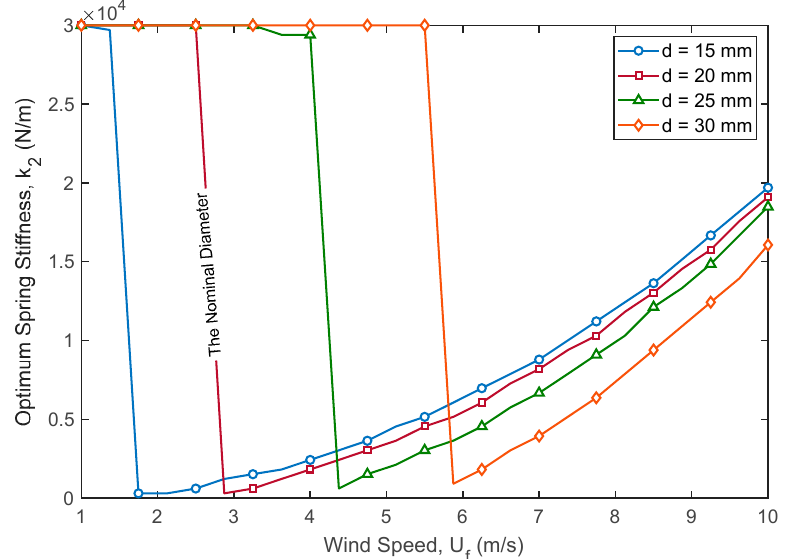
Figure 11. Optimum spring stiffness at various diameters of cantilever beam of the tunable turbine.